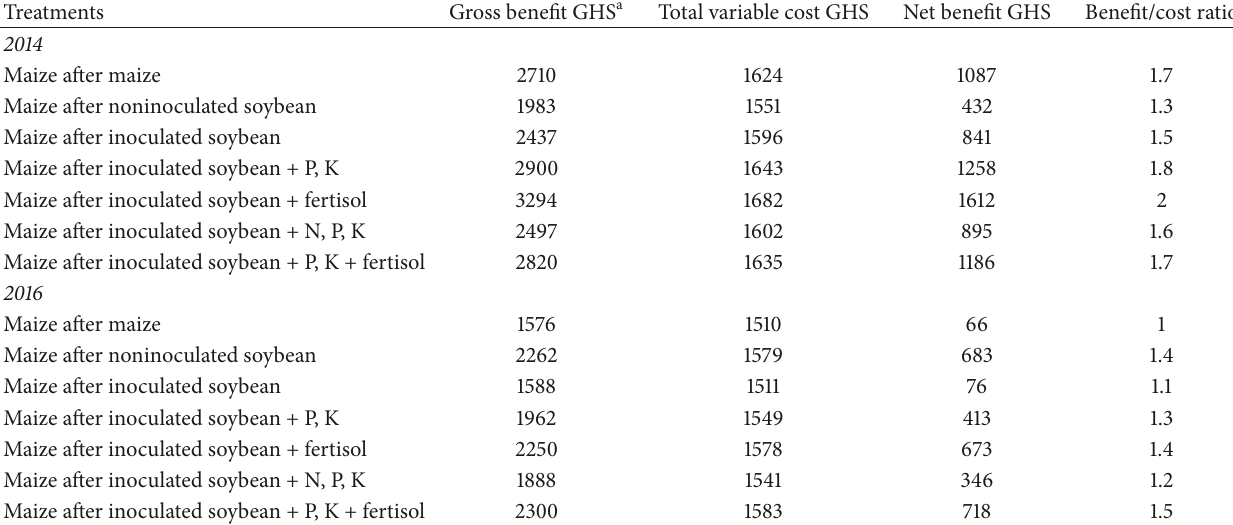
Table 4: Economic benefits of soybean and maize rotation under different soil amendments in the northern savanna of Ghana.